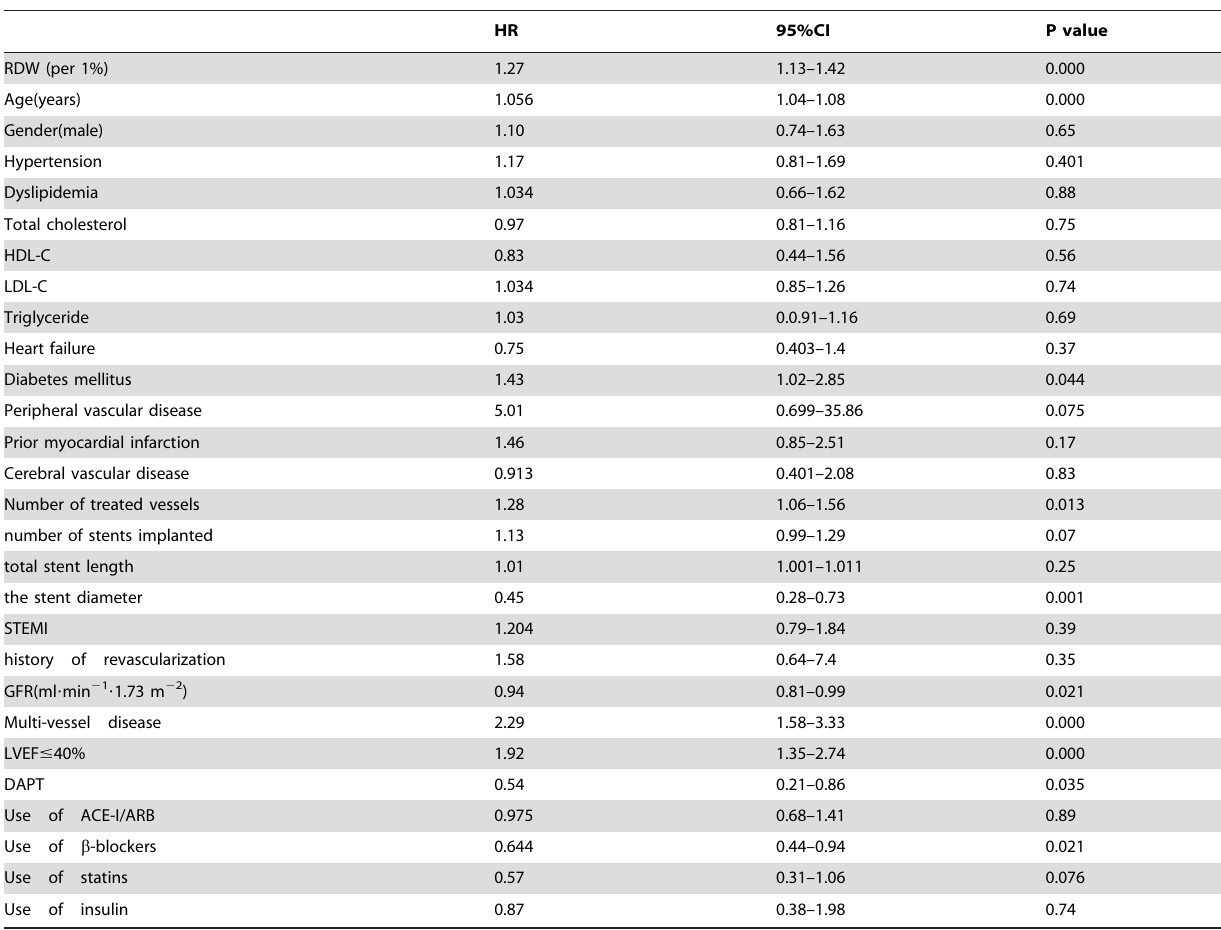
Table 5. Univariate Analysis for MACCE.